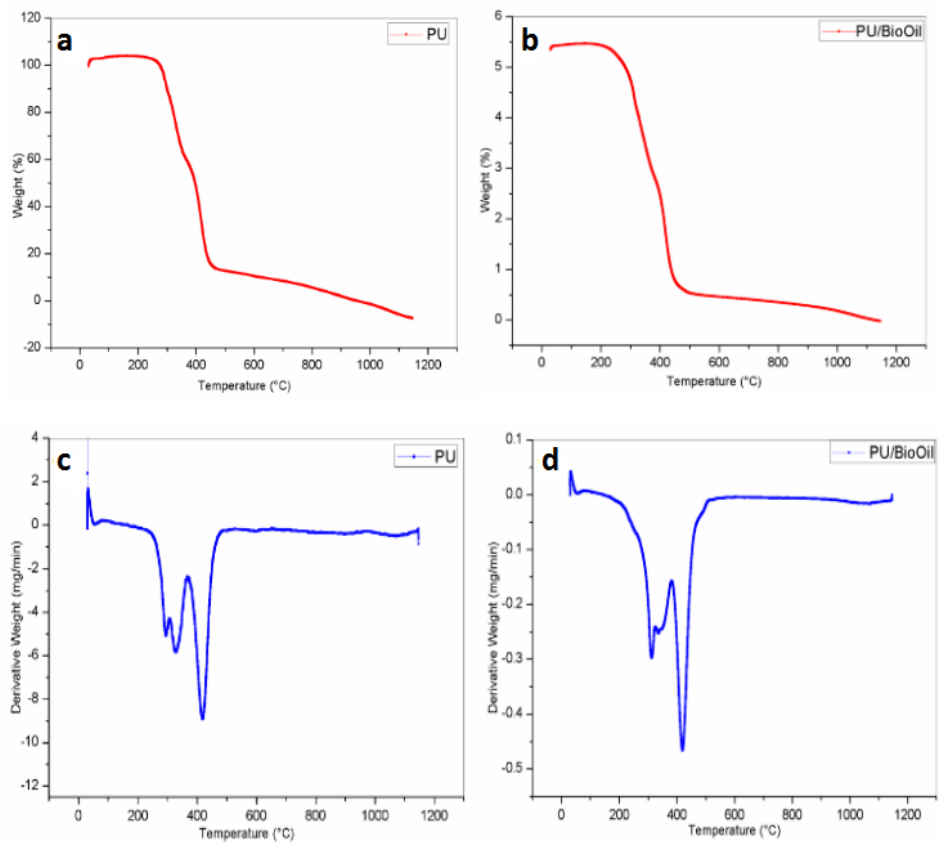
Figure 4 - TGA analysis of a ) Pure Polyurethane b ) Polyurethane/bio oil TM composites c ) Weight residue percentage of Pure PU and d ) Weight residue percentage of PU/bio oil TM